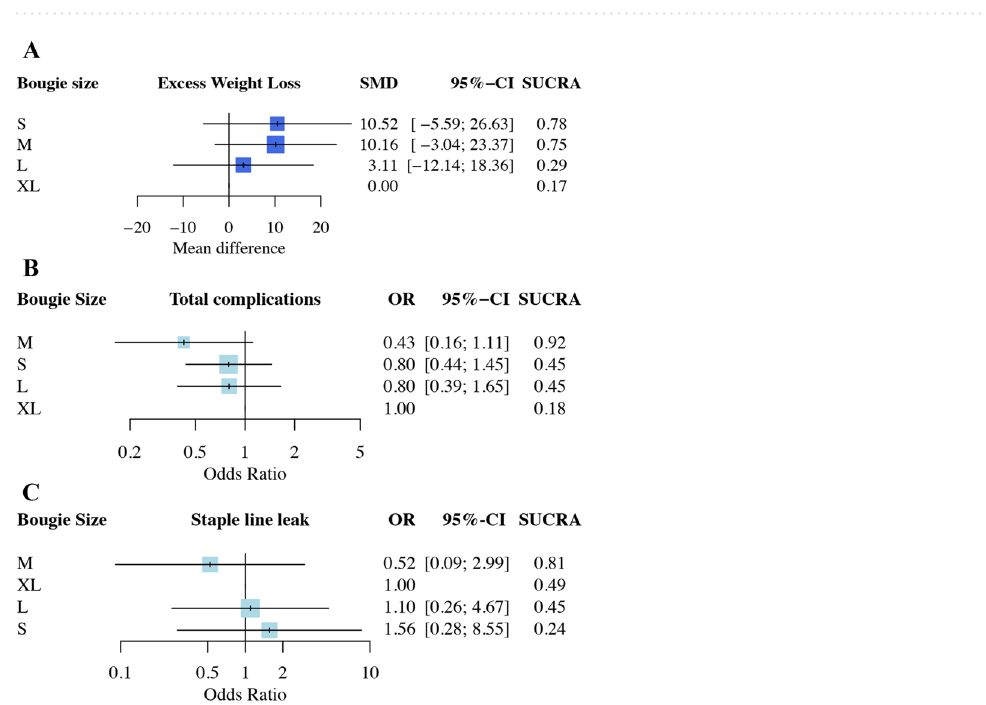
Figure 2. ( A ) Network structure of outcome measure (excess weight loss). Network plot of excess weight loss comparisons. The picture was created with Adobe Photoshop CC 2018 and Sketch Version 45.1 software. ( B ) Network structure of outcome measure (total complications). Network plot of total complication comparisons. The picture was created with Adobe Photoshop CC 2018 and Sketch Version 45.1 software. ( C ) Network structure of outcome measure (staple line leak). Network plot of staple line leak comparisons. The picture was created with Adobe Photoshop CC 2018 and Sketch Version 45.1 software.